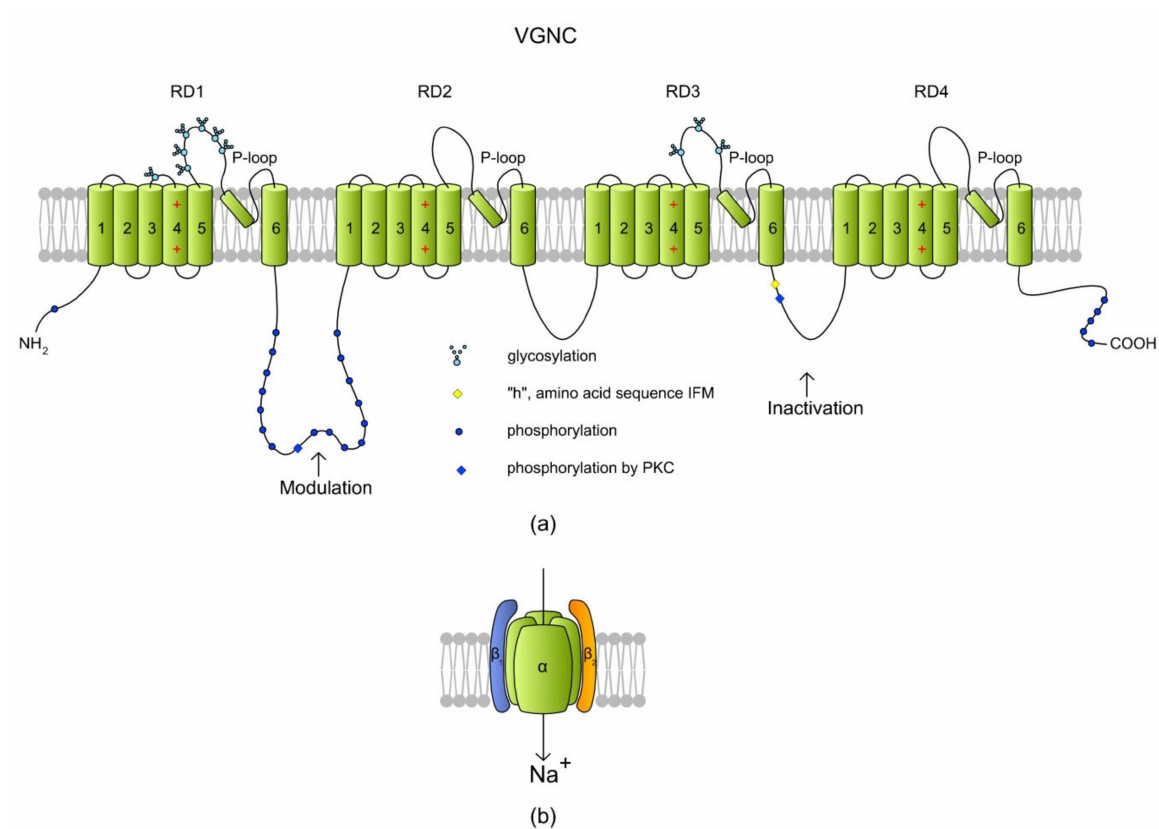
Figure 6. A structure of a voltage-gated Na + channel (VGNC) based on a SCN2A isoform. ( a ) The α subunit is created by four repeat domains (RD1–RD4) that each have six TMs. Classically, TM1–TM4 of each domain form a VSD where TM4 acts as a positively charged sensor. During depolarization, TM4 is believed to move toward the extracellular surface, allowing the channel to become permeable to ions. Na + is transported inside a cell through a pore (P-loop) formed between TM5 and TM6 of each RD. The RDs are connected with long intracytoplasmic loops with sites for protein phosphorylation via PKA and PKC [157]. The cytoplasmic loop between RD3 and RD4 contains an “h” (I × F × M sequence) motif, which stands for a hydrophobic triad of amino acids, namely, isoleucine, phenylalanine, and methionine (I1488, F1489, and M1490). The IFM motif is involved in the inactivation of VGNC, serving as a hydrophobic latch for a hinged lid formed by the loop between RD3 and RD4 [159]. Phosphorylation in the RD1/RD2 and RD3/RD4 loops modulates the channel inactivation (adapted from Reference [157], revised in Reference [160]). ( b ) A cartoon of VGNC created by the pore-forming α subunit and the two auxiliary β